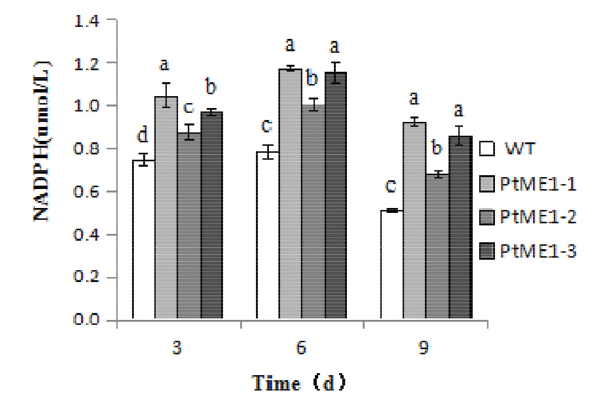
The values in the same row with different superscripts represent statistically significant differences (P < 0.05). Values represent averages of three replicates (n = 3).